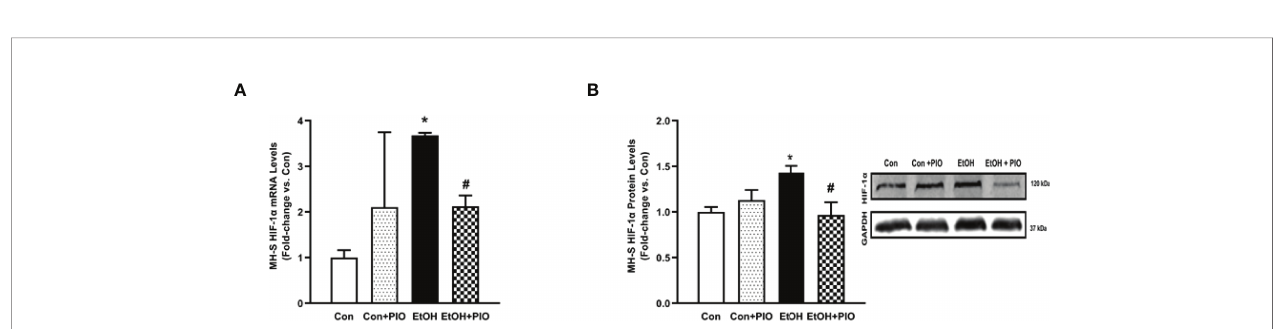
FIGURE 7 | HIF-1 a modulates EtOH-induced glycolysis and phagocytic function in MH-S. MH-S transiently transfected with control scramble (SCR) or siRNA against HIF- 1 a (siHIF1 a ) were exposed to either Con or EtOH (0.08%) for 72 hours. (A) Oxygen consumption rates (OCR) and extracellular acidi fi cation rates (ECAR) were measured in response to an injection mixture of oligomycin (oligo; mitochondrial complex V inhibitor) and carbonilcyanide p-tri fl ouromethoxyphenylhydrazone (FCCP; ATP synthase inhibitor and proton uncoupler) using an extracellular fl ux analyzer. Cell energy phenotype was measured, normalized to protein levels, and are expressed as mean ± SEM (n = 5). ECAR were measured in response to sequential injections of glucose (saturating concentration of glucose to promote glycolysis), oligomycin (ATP synthase inhibitor), and 2-deoxy-glucose (2-DG; a glucose analog that inhibits glycolysis) using an extracellular fl ux analyzer. OCR measures are pmol over time and ECAR measures are mpH over time, normalized to total protein in the same sample well, and are expressed as mean ± SEM. (B) Phagocytic index was calculated from the percentage of cells positive for bacterial uptake multiplied by the RFU of S. aureus per cell. Values are expressed as mean±SEM relative to vehicle (n = 6). * p < 0.05 versus control; # p < 0.05 versus ethanol.